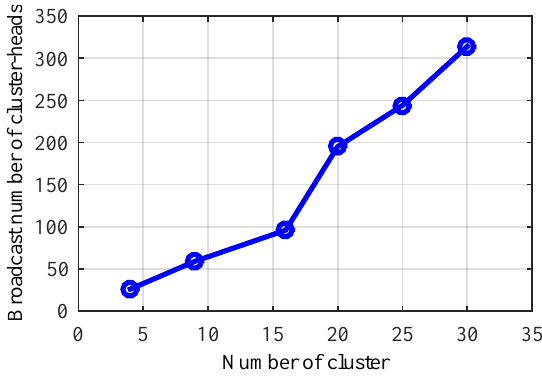
Figure 7. Communication overhead of CMTS in inter-cluster time